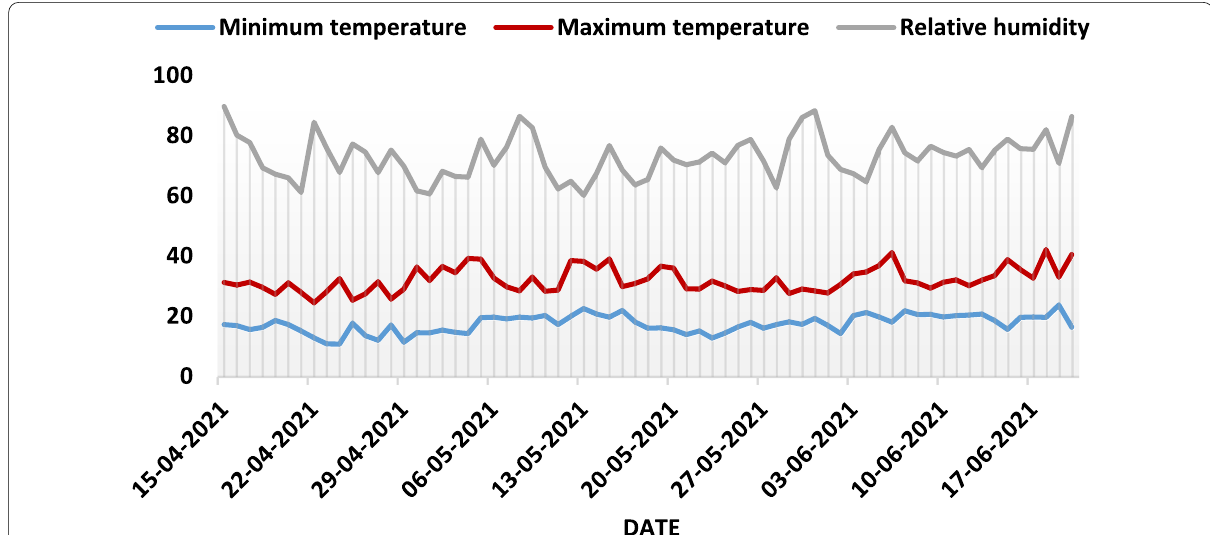
Fig. 1 Minimum temperature, maximum temperature and relative humidity data inside the test